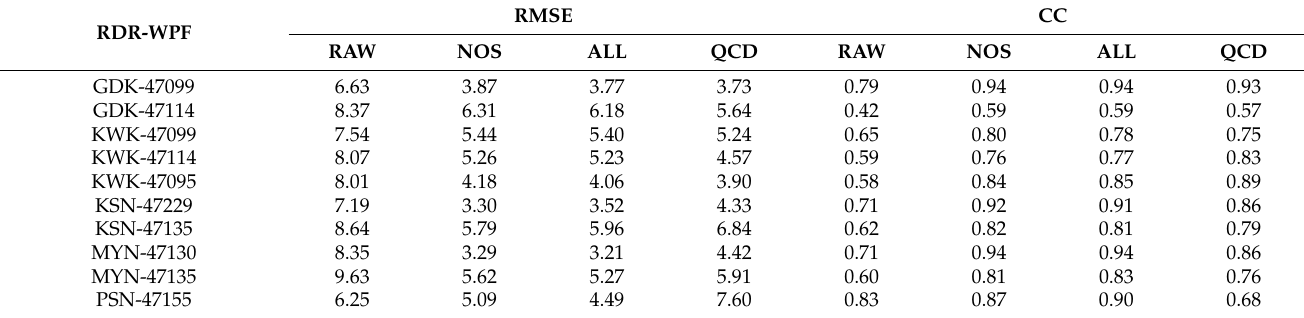
Figure 17. Same as Figure 15. ( a – d ) KSN-47229, ( e – h ) GDK-47114, ( i–l ) PSN-47155. Table 3. Quantitative verification results for each stage of the radial velocity quality control